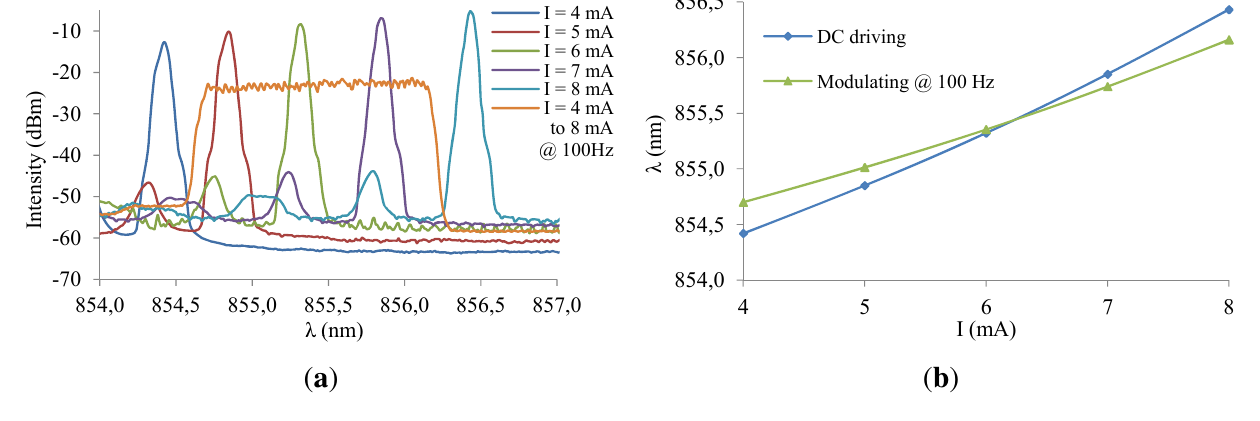
Figure 10. Dynamic wavelength range of the VCSEL. ( a ) Spectral intensity of the VCSEL measured using an Optical Spectrum Analyzer; ( b ) Wavelength tuning characteristics of the